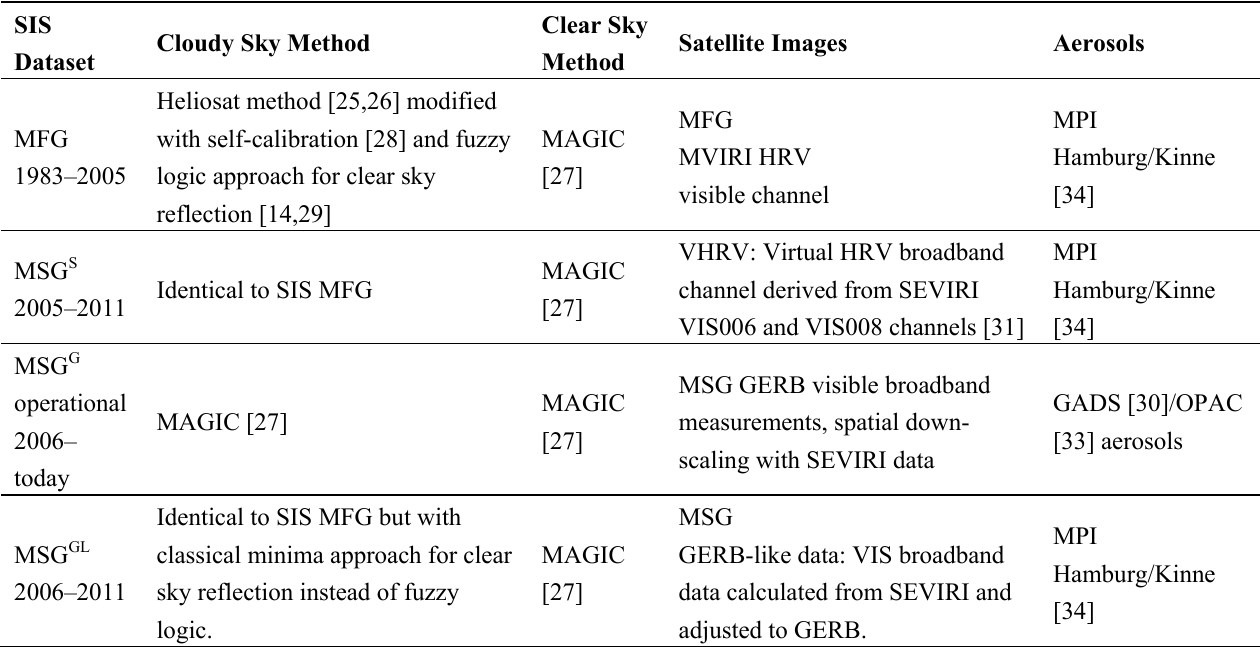
Table 1. Overview of the different methods and satellite images used to generate the data sets. SIS